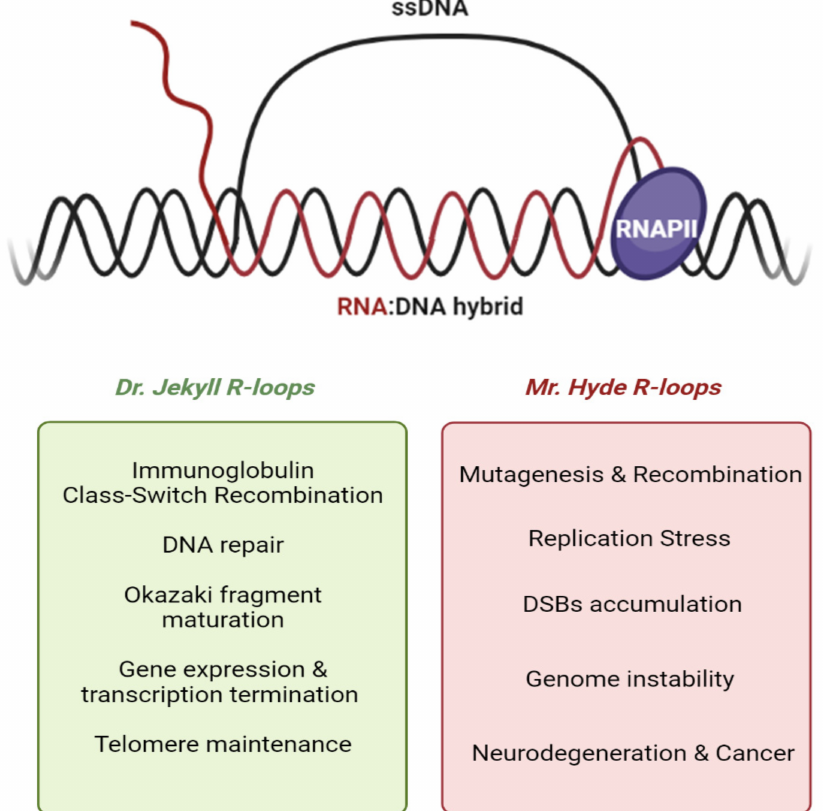
Figure 1. ( Top ) Schematics of R-loop structure showing RNA:DNA hybrid formed between the nascent RNA (in red) and the transcribed DNA template, while a non-transcribed template is displaced as ssDNA. ( Bottom ) In the green box are listed the main and most studied implications of R-loops in physiological contexts. In the red box, conversely, are listed the most noteworthy roles of persistent and detrimental